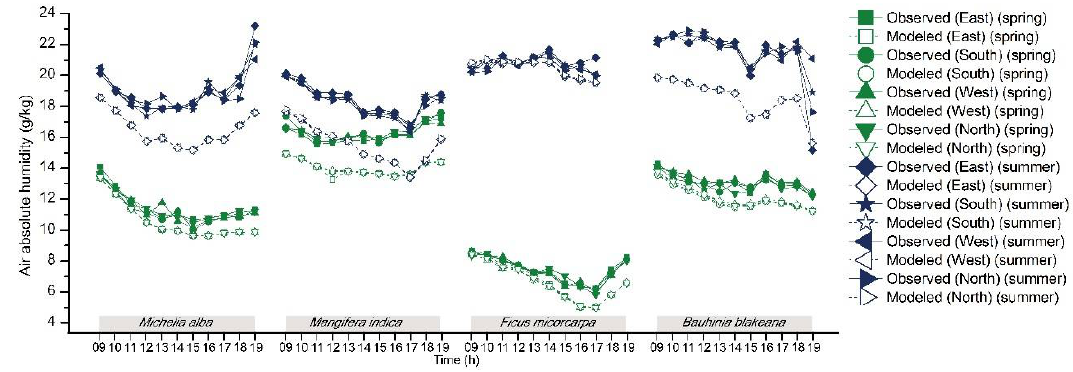
Figure 13. Comparison of modeled and observed air absolute humidity in the tree crown in four directions.